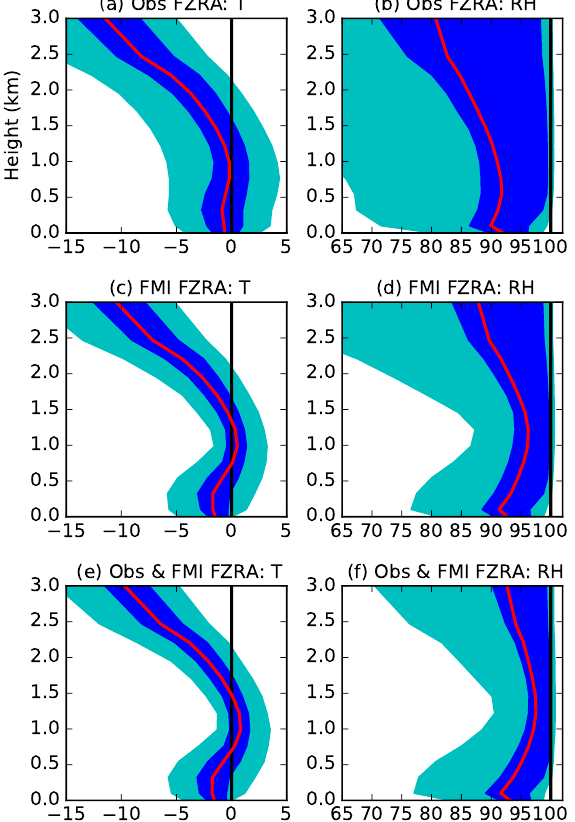
Figure 7. Vertical profiles of temperature ( ◦ C, left column) and relative humidity (%, right column) of ERA-Interim at weather station locations. 5–95% range (cyan), 25–75% range (blue) and mean (red) are shown. Top row: profiles when FZRA was reported in SYNOP messages (11000 events in total). Middle row: FZRA profiles according to the calibrated FMI CLIM algorithm (11000 events). Bottom row: profiles where both the FMI CLIM algorithm and observations indicated FZRA (2300